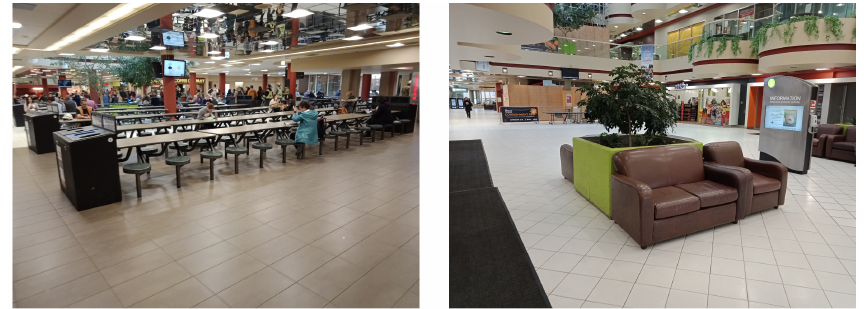
Figure 3. Test environment.